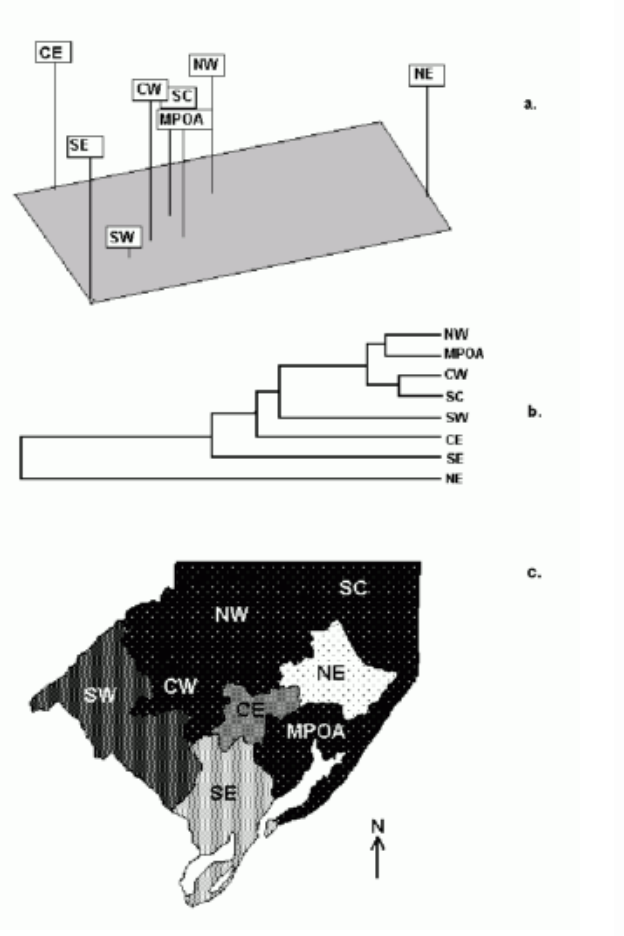
Figure 3 - Multivariate analyses of the distribution of surnames: (a) princi- pal coordinates, (b) dendrogram obtained from the D A distances, (c) map of both distributions. Shading is arbitrary, but indicates the major associations among